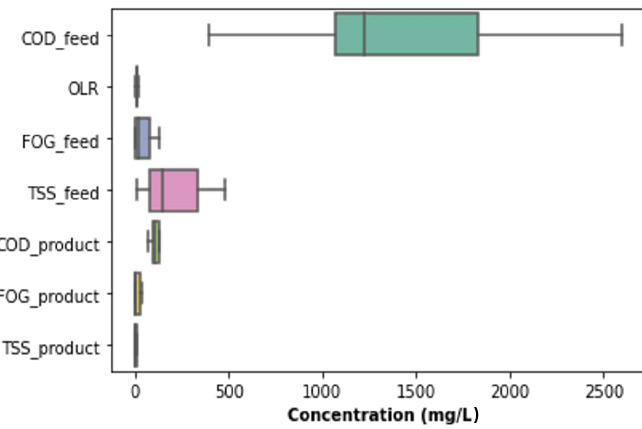
Figure 10. Boxplot of the EGSB parameters .